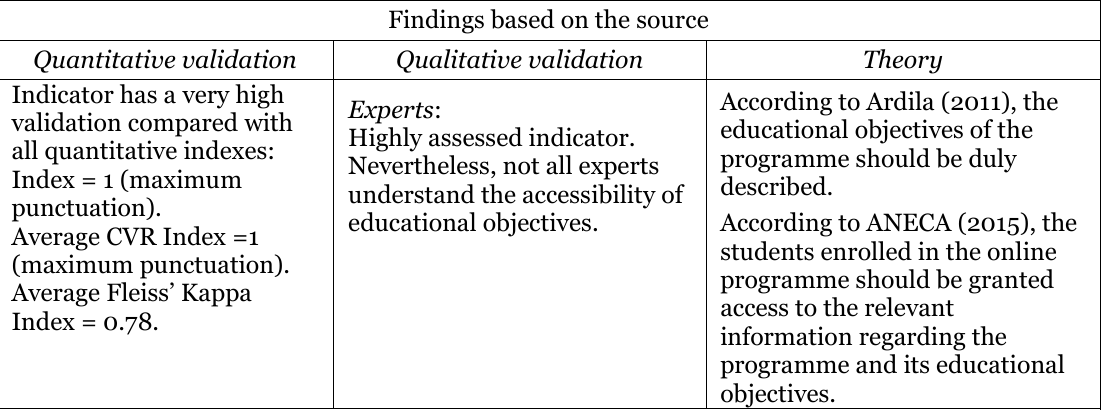
Example of Triangulation of the Data for One of the Indicators of the Model Indicator: Accessibility and disclosure of the educational objectives Findings based on the source Quantitative validation Qualitative validation